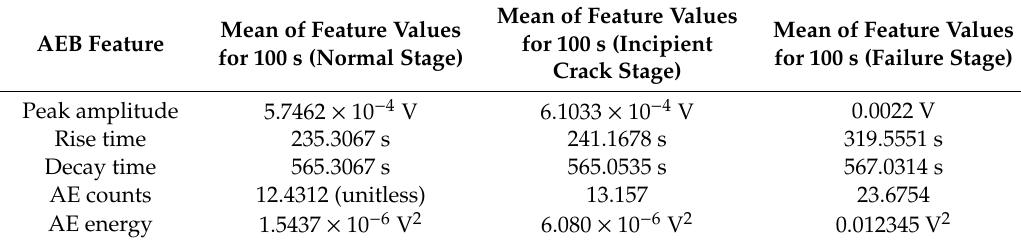
Table 3. Mean values of di ff erent acoustic emission (AE) features in every 100 s of the healthy (normal mode) and faulty condition (fracture mode).